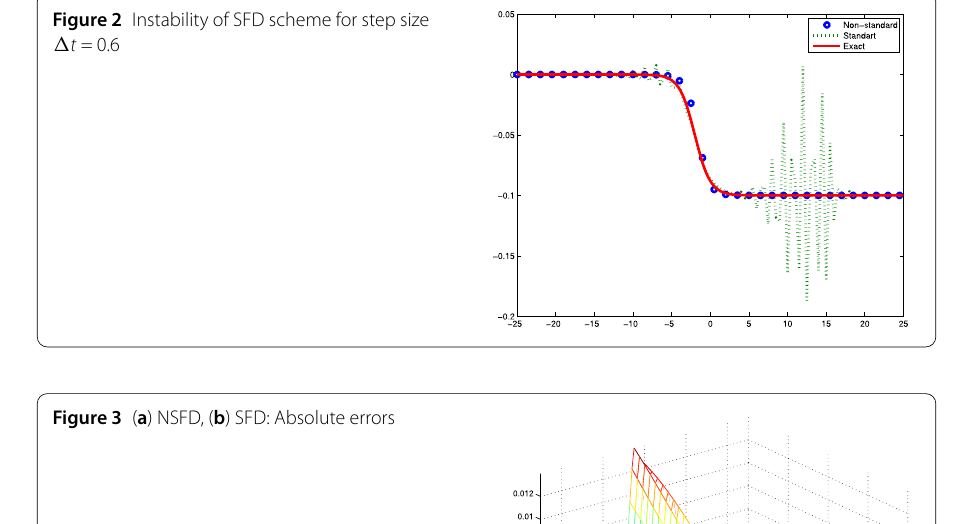
Figure 2 Instability of SFD scheme for step size (cid:3) t =